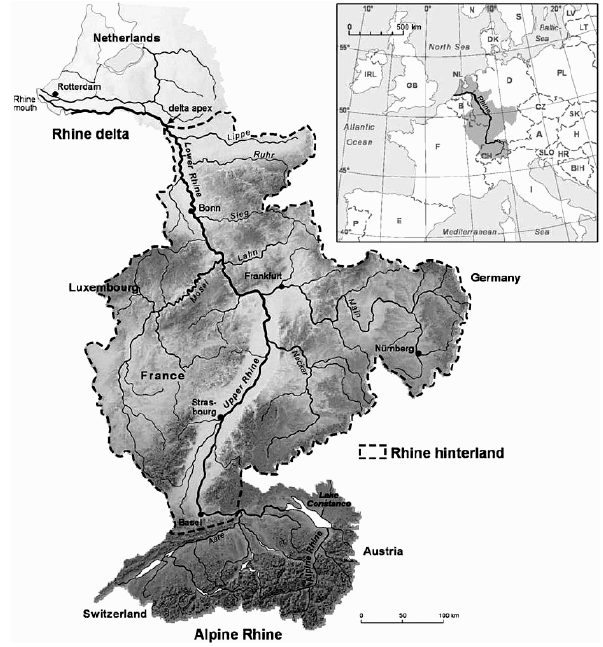
Figure 2. The Rhine catchment (Hoffmann et al., 2013).